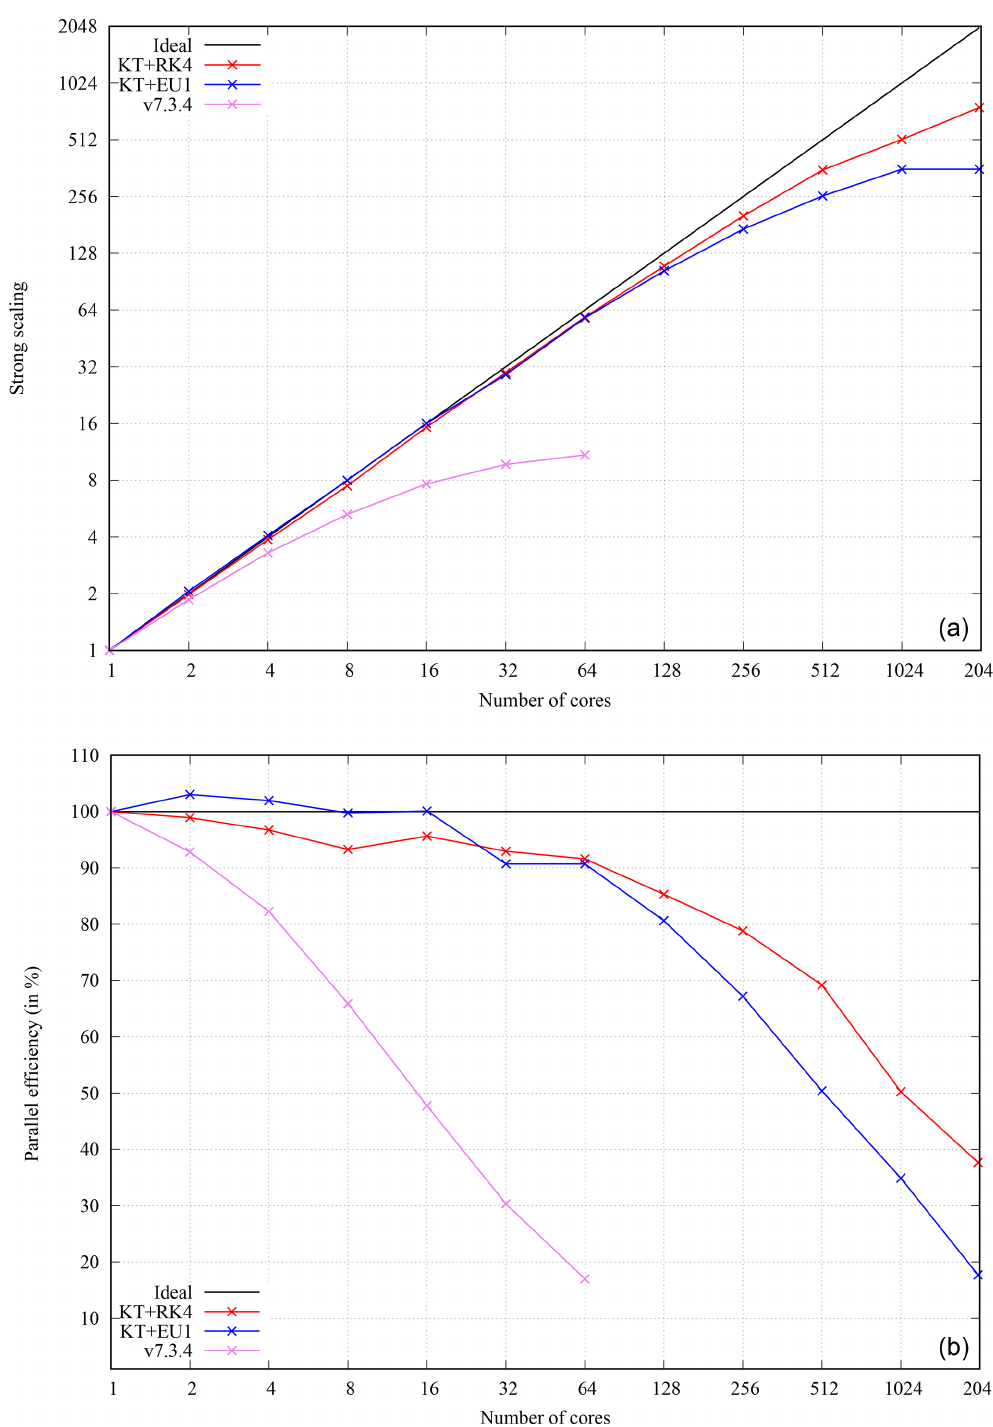
Figure 8. Strong scaling results on MareNostrum 4 supercomputer for the Cordón Caulle simulation using a 500 × 500 × 100 cell grid. (a) Scaling curves up to 2048 processors for the RK4 (red) and EU1 (blue) time integration schemes. Results using code v7.3.4 are also shown with up to 64 processors only (pink). Ideal strong scaling behaviour is indicated by the solid black line. Note that the scaling curves refer to the total computing time and therefore include I/O operations, not just computing time. (b) Parallel efficiency (Eq. 83) depending on the number of computation